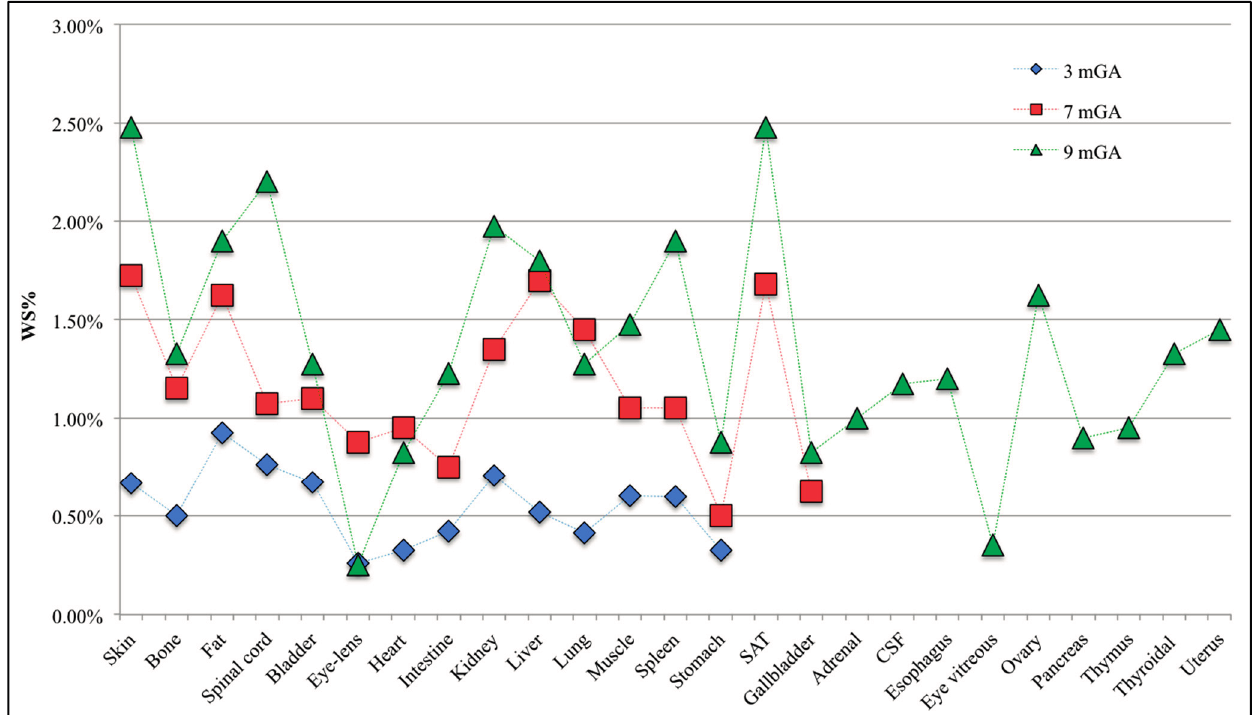
Figure 5. Worst-case scenario (WS%) in all the tissues of the head (excluding the CNS) and body for the mE 99th found among the 10,000 values of E 99th calculated from the PC expansion, changing randomly the B